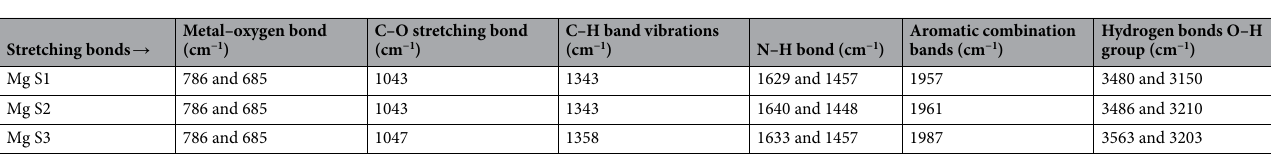
Table 1. Position of characteristic stretching modes in FTIR spectra of MgS1, MgS2, MgS3